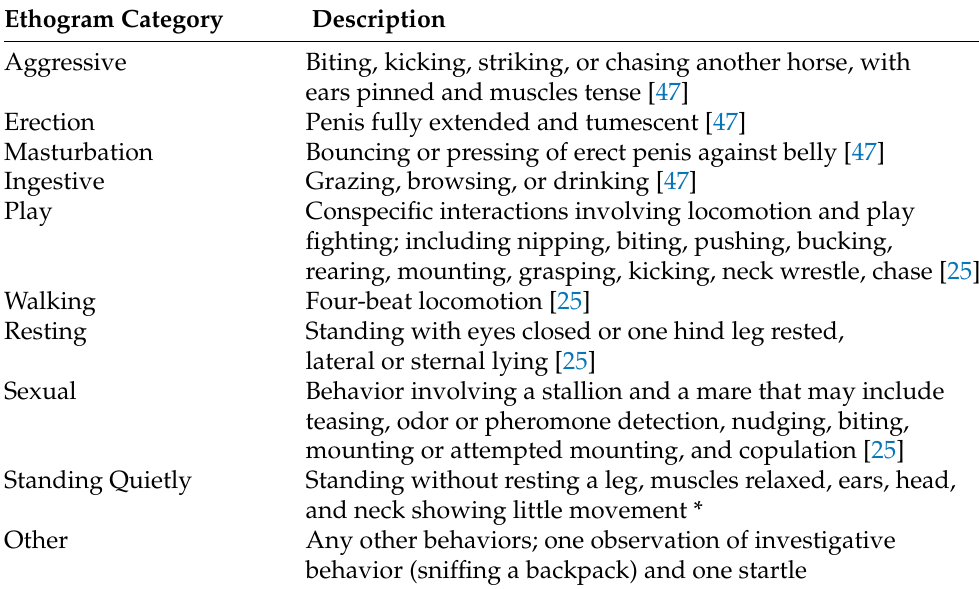
Table 2. Ethogram of stallion focal behaviors and categories of behaviors that occurred before and after erection and masturbation